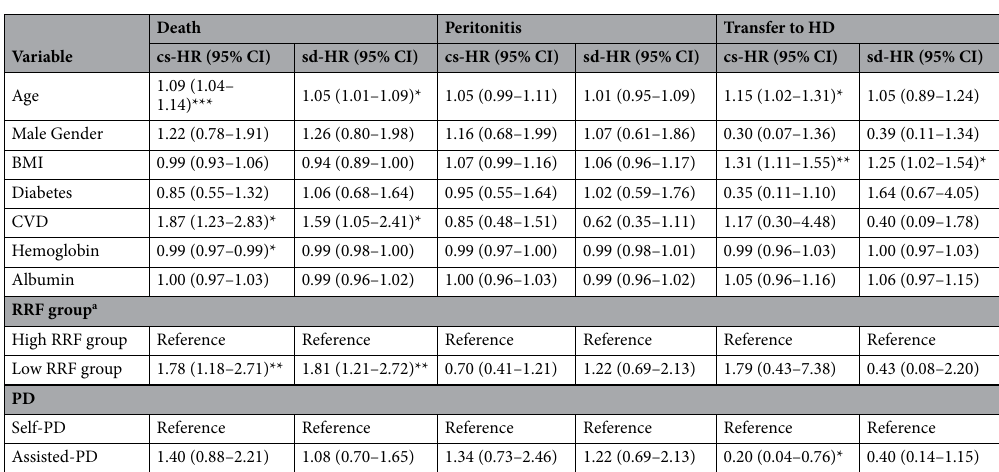
Table 4. Adjusted cs-HRs (Cox model) and sd-HR (Fine and Gray model) for each event. Abbreviations: cs-HR cause-specific hazard ratio, sd-HR subdistribution hazard ratio, CI confidence interval, BMI body mass index, CVD cardiovascular disease, RRF residual renal function. * P < 0.05, ** P < 0.01, *** P < 0.001. a RRF group was defined as: high RRF group, residual renal function (RRF) > median; low RRF group, residual renal function (RRF) <